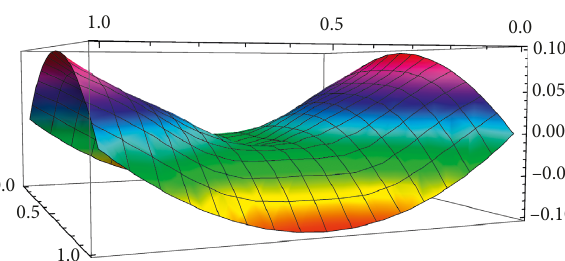
Figure 17: Second order ( t � 0.002s).